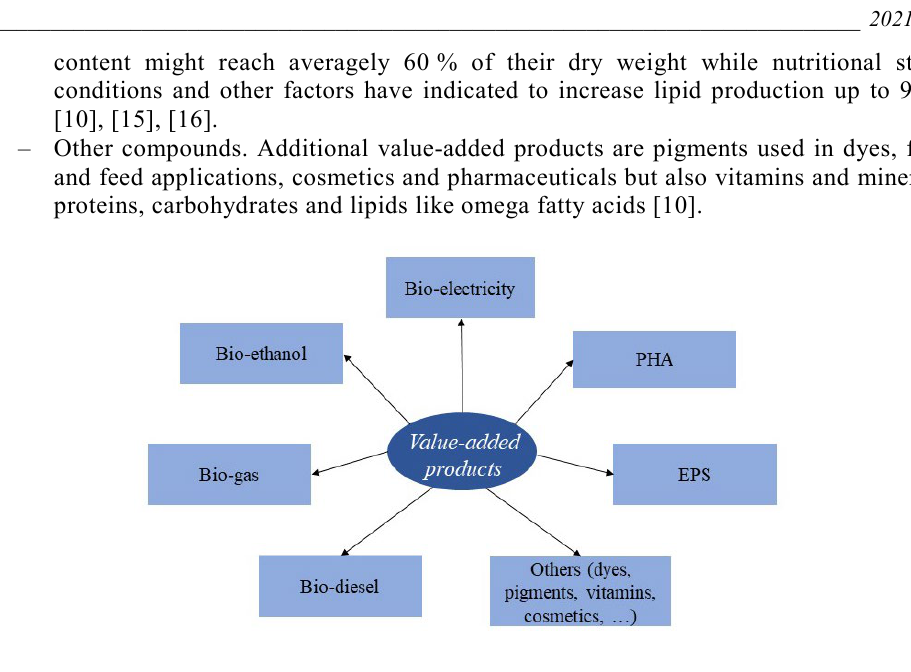
Fig. 3. Scheme of possible value-added compounds that might be produced directly by microalgae or by processing microalgal